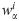
Dilogo for the motif of the TF NRF1.The top row of the dilogo shows the familiar sequence logo representation of the marginal probabilities wαi for each of the letters α at each position i. The posterior probabilities for dependency between each pair of positions are shown in the square lattice at the bottom of the dilogo, with darker red color indicating higher probability of dependence. Above this square lattice a graph with significant pairwise dependencies is shown: an arrow from node j to i indicates that the probability of a particular letter at i depends on the letter appearing at j. Finally, for each position i that depends on another position j, the probabilities P(si|sj) are shown in sequence logo format, with each row corresponding to the identity of the parent letter sj and each column showing the probabilities P(si|sj) for the child letter si.